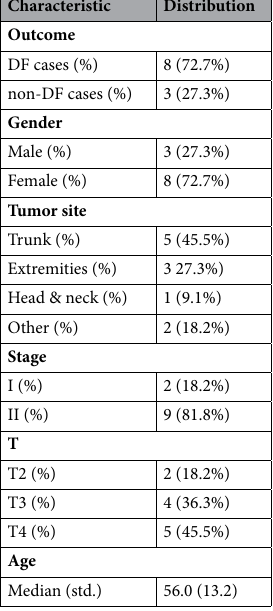
Table 2. Clinical data referred to the validation cohort of patients. For categorical variables, percentage (%) counts are reported. For continuous values, the median and standard deviation (sd.) values are indicated. The tumor site labelled as ‘Other’ was the gluteus muscle for both patients.